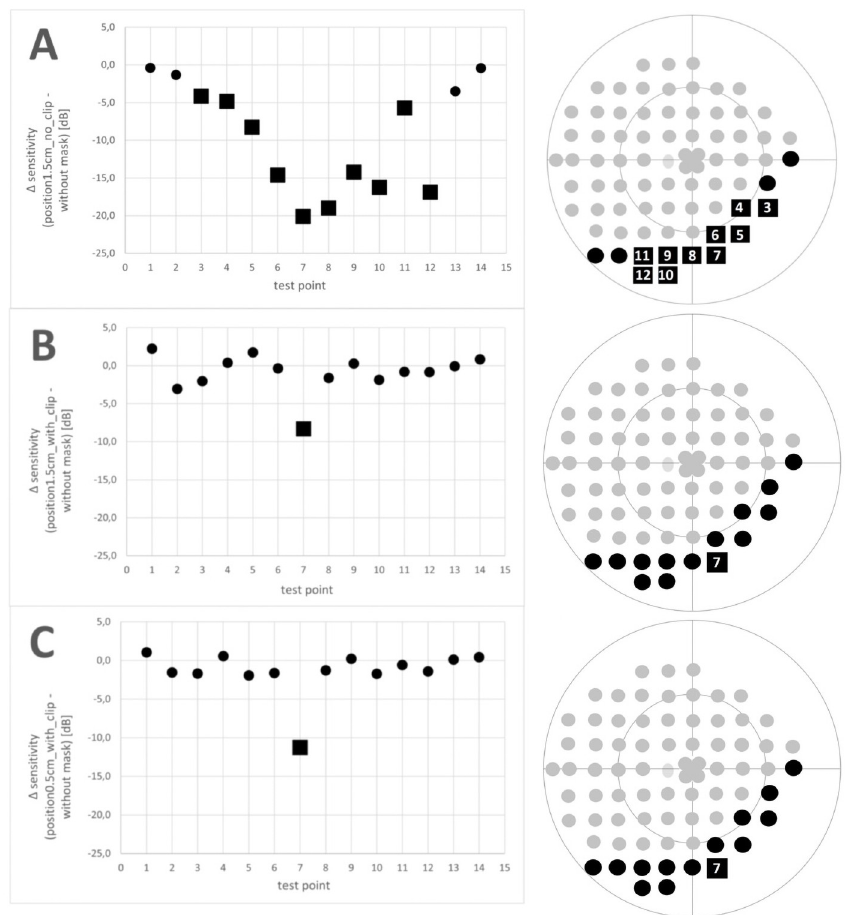
Fig 3. Differences in sensitivity between the different mask positions (A: Position 1.5cm_no_clip ; B: Position 1.5cm_with_clip ; C: Position 0.5cm_with_clip ) and without wearing a mask ( Δ ): Mean Δ sensitivity; the square represents significant differences (p < 0.05), the circle represents no significant difference; significant reductions Δ were observed for P7 (all three positions) and P8 (position 1.5cm_no_clip ).